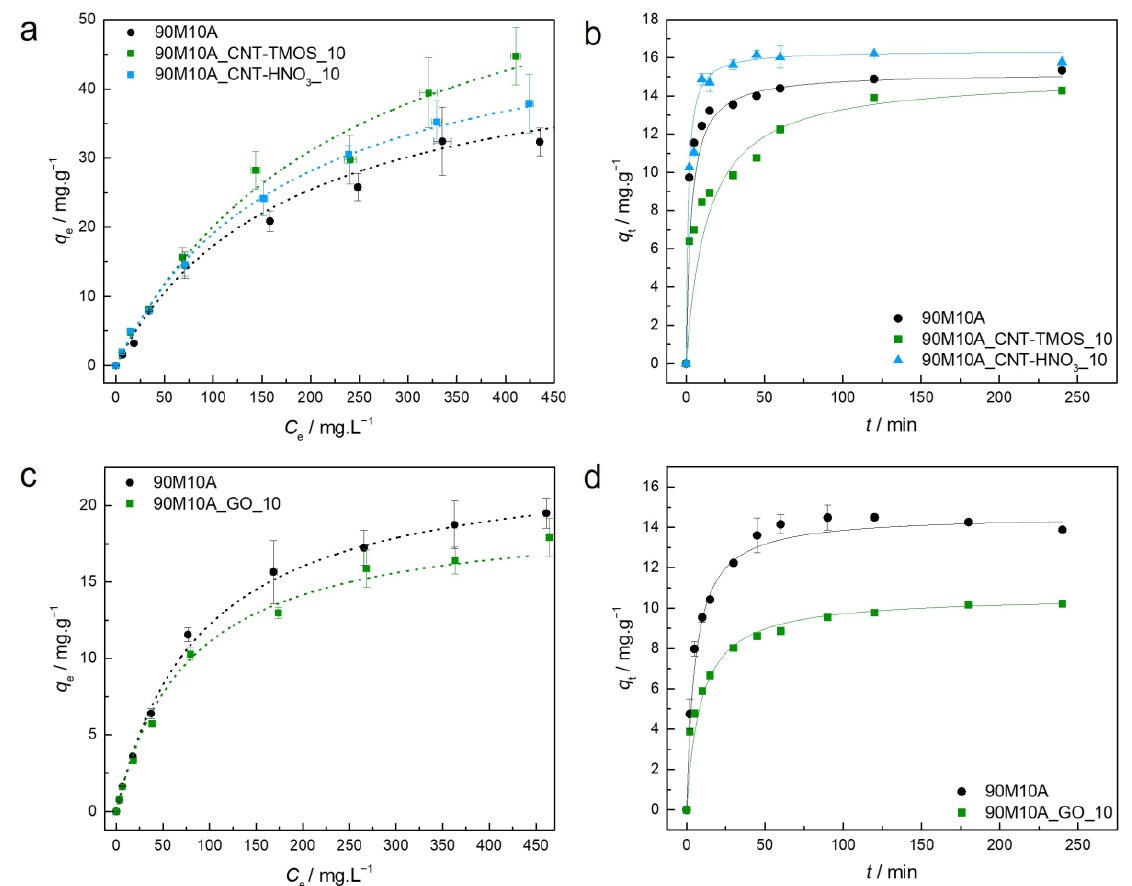
Figure 5. ( a , c ) — Experimental equilibrium data and the best fitted isotherm model for adsorption of phenol into the studied aerogels (dotted line — Langmuir). ( b , d ) — Representative plots of the fit of non-linearized form of pseudo-second order equation (solid line) to the data of experimental adsorption capacity as function of time, for the studied adsorbents towards phenol ( C 0 = 100 ppm, 15 rpm, 20 °C).